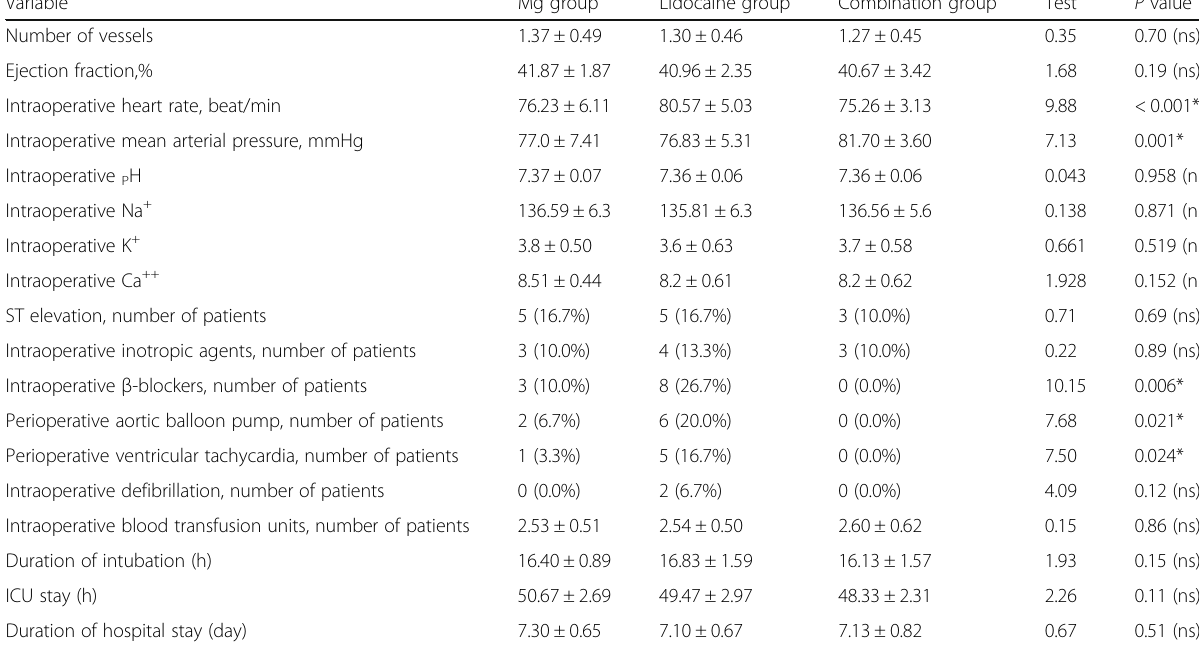
Table 2 Perioperative and outcome data Variable Mg group Lidocaine group Number of